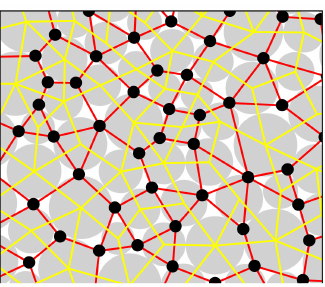
Figure 1. The fluid network used for fluid-mechanical simulation in PFC 2D model (gray circles: solid particles, red lines: flow channels, black circles: